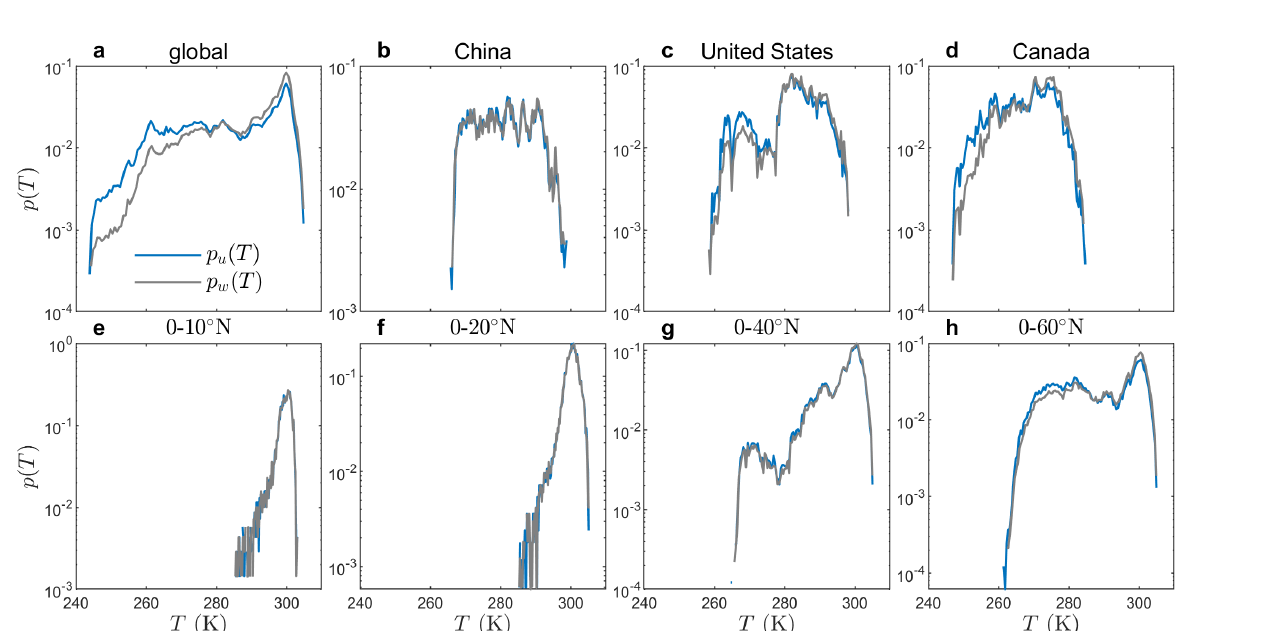
Figure 7. As in Figure 2 but for temperature distributions with and without consideration of geodetic weights ( p w ( T ) and p u ( T )